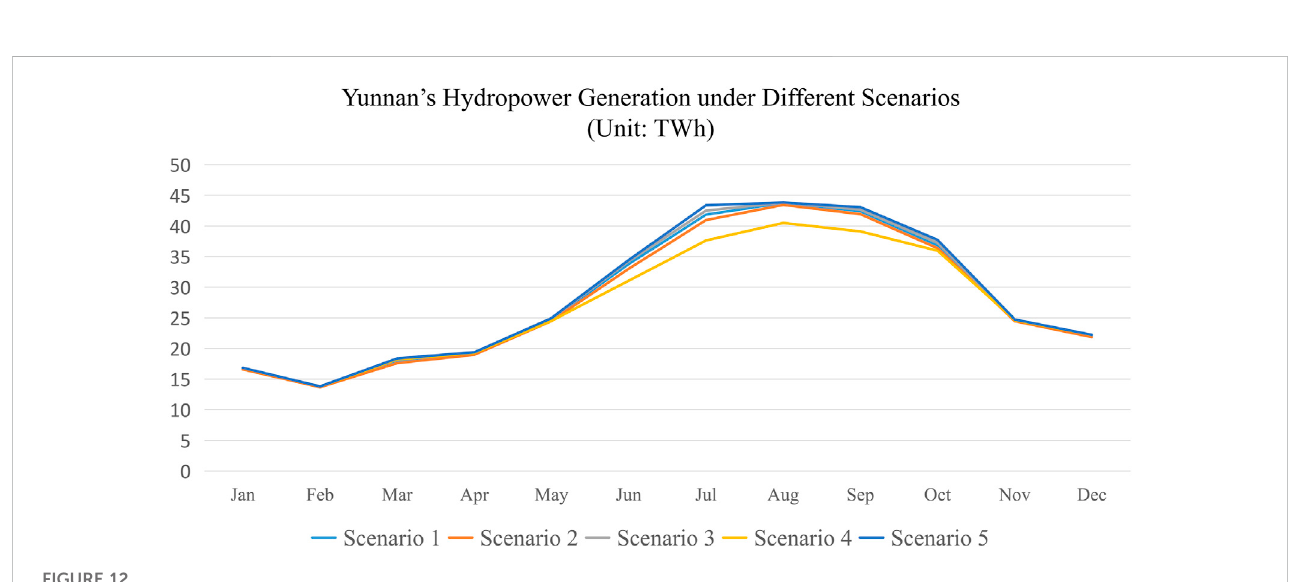
FIGURE 12 Yunnan ’ s hydropower generation under different